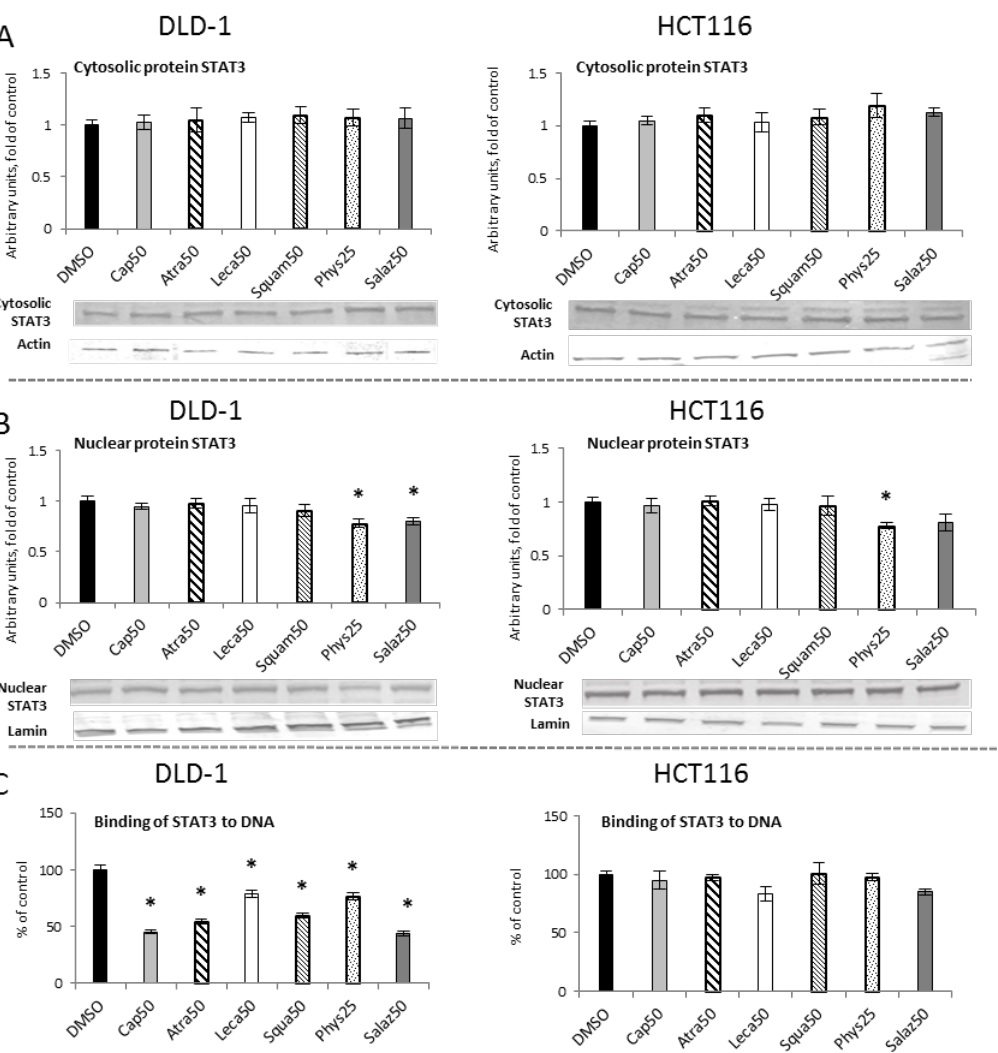
Figure 9. The effect of lichen-derived compounds on STAT3 activation in DLD-1 and HCT116 cells. ( A ) The level of STAT3 protein in the cytosolic fraction. ( B ) The level of STAT3 protein in the nuclear fraction. Representative Western immunoblots are presented under the graphs ( A , B ). Results (means ± SEM from three separate experiments) are presented as a fold change to control after normalization against the level of actin or lamin. ( C ) The level of STAT3 binding to DNA. Results are presented as the means ± SEM from three separate experiments percentage of control). Asterisks (*) denote statistically significant changes from the control group ( p ≤ 0.05). DMSO , vehicle control; Cap50 , caperatic acid (50 µM); Atra50 , atranorin (50 µM); Leca50 , lecanoric acid (50 µM); Squam50 , squamatic acid (50 µM); Phys25 , physodic acid (25 µM); Salaz50 , salazinic acid (50 µM).